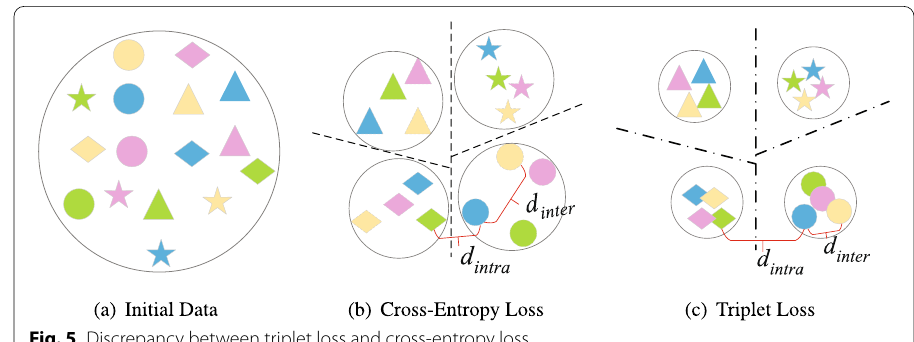
Fig. 5 Discrepancy between triplet loss and cross-entropy